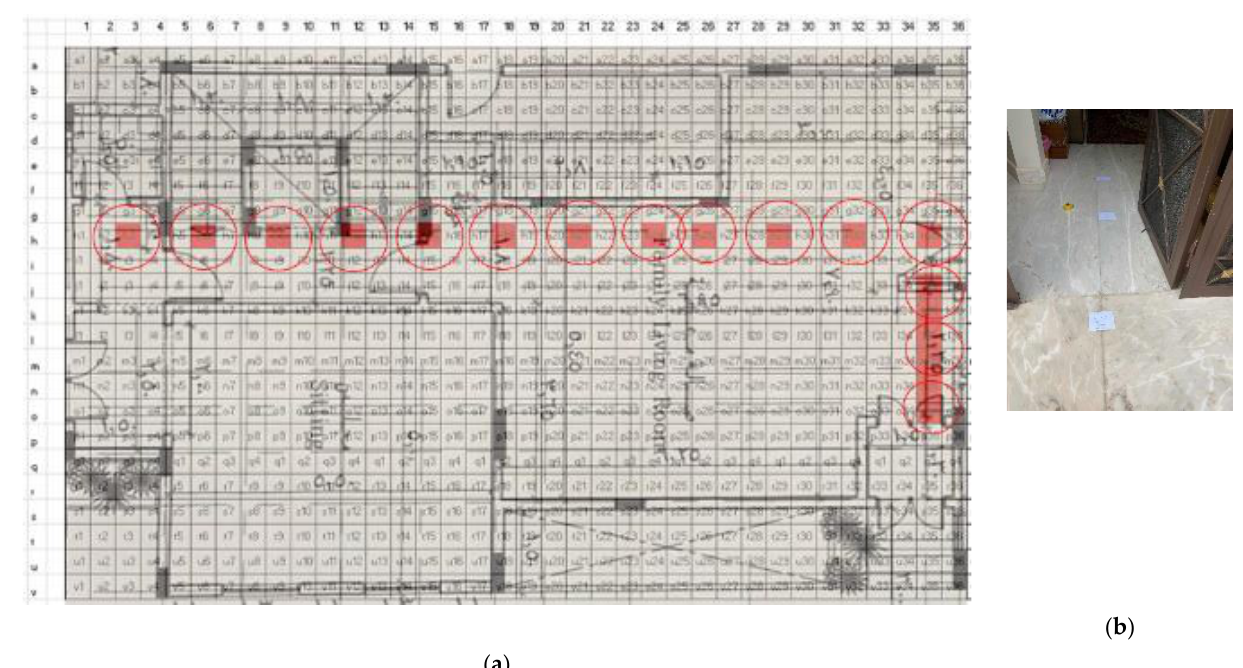
Figure 23. Remarkable points, labeled as locations. ( a ) Blueprint with grids of North and East coordinates and the location points marked alongside the path. ( b ) picture of points in building.